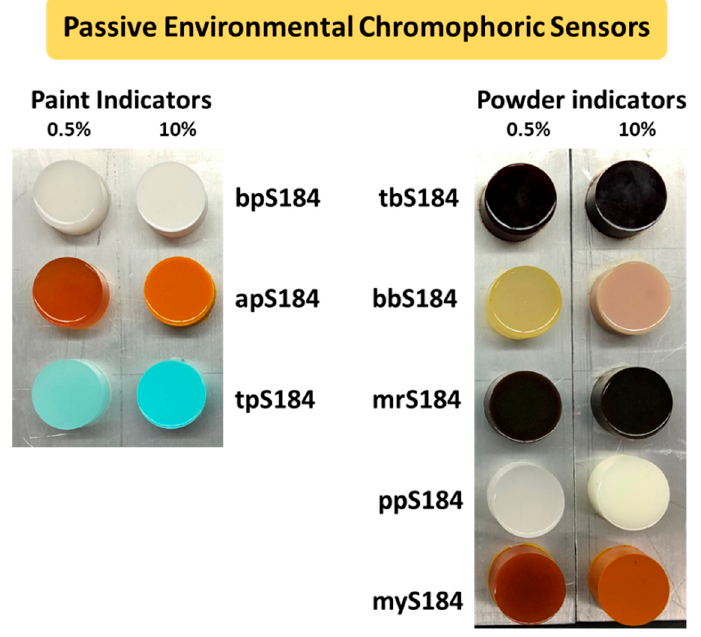
Figure 1. Pristine composite passive environmental chromophoric sensors separated by indicator weight percent (0.5 wt.% on the left and 10 wt.% on the right of each photo) and by the initial indicator form (paint-based on the left and powder-based on the right).